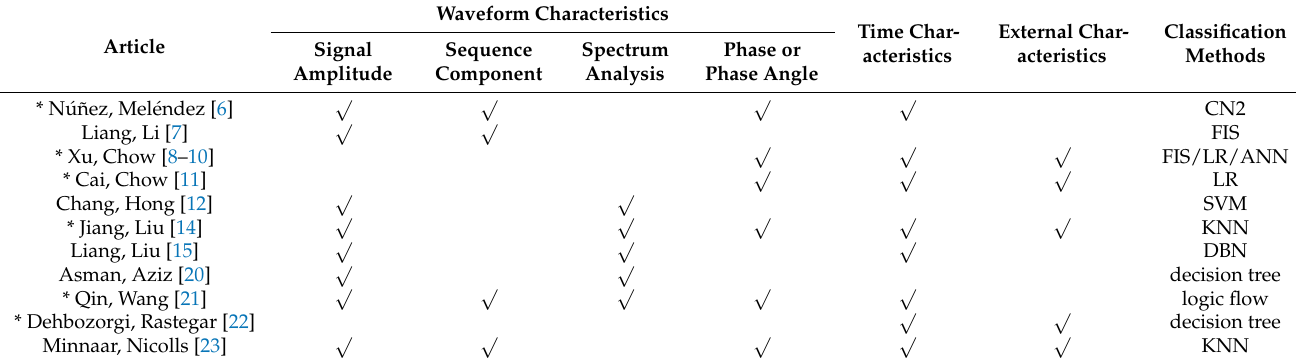
Table 1. A summarized list of characterization and classification methods used for fault-cause